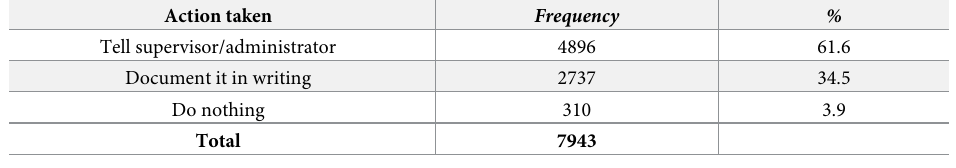
Table 10. Respondents’ � channel for documentation of perceived ineffective oxytocin reported. Channel Frequency % Case note 1531 52.9 Patient chart 134 4.6 Total 2890 � Multiple response